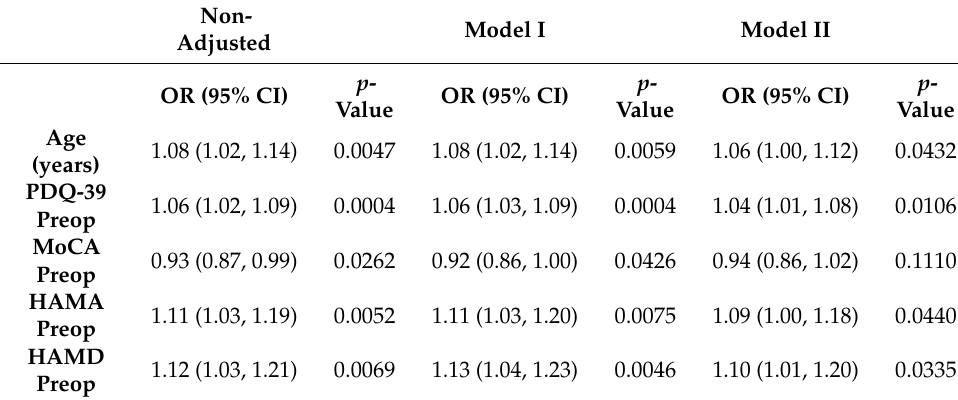
Table A3. Multivariate regression showing the effect of age, PDQ-39 Preop, MoCA Preop, HAMA Preop and HAMD Preop on the improvement rate of